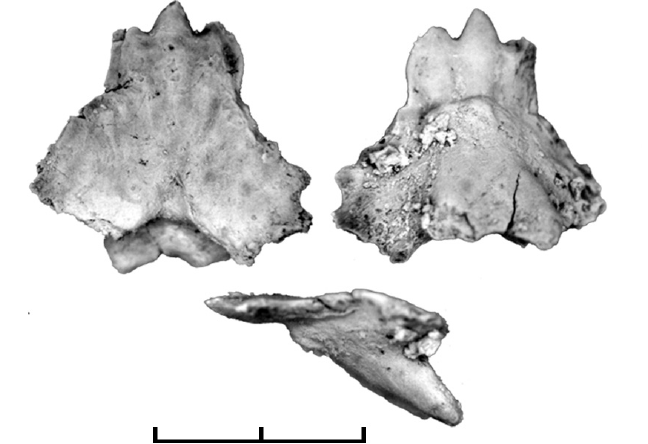
Figure 3. Paddlefish denticle from the Milk River Formation, UALVP 49032. Scale bar equals 2